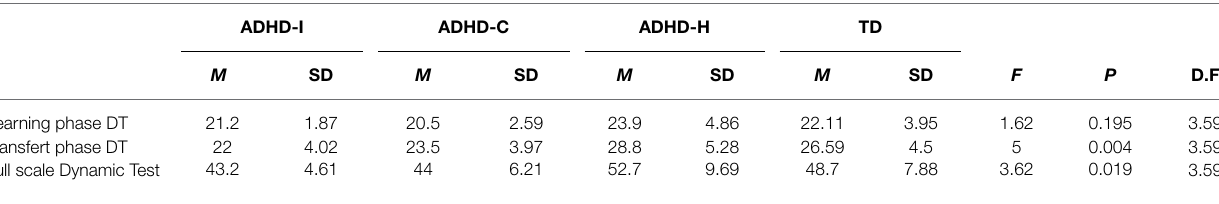
TABLE 3 | Means, Standard deviations, and statistical test for each group and for each subtest of the DT.